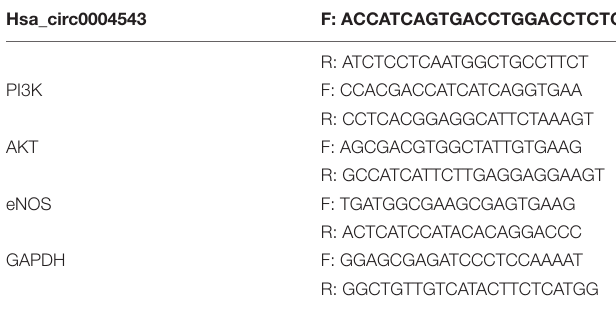
TABLE 1 | Primer sequences of the genes